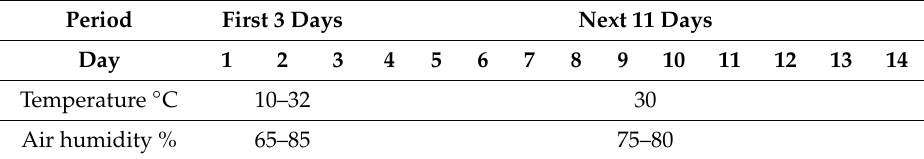
Figure 2. Callusing boxes with sawdust substrate ( a ), covered with Geotextil canvas, and a layer of 5 cm on sawdust ( b ). Table 2. Evolution of temperature and air humidity during